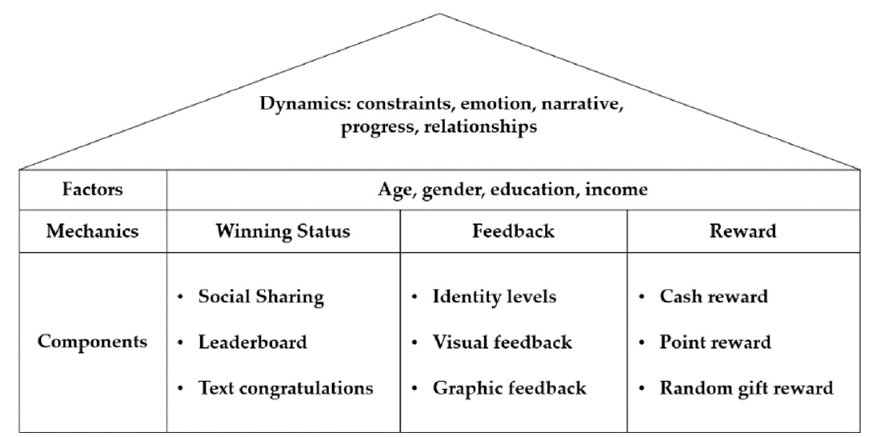
Figure 5. The modified gamification model for older users.